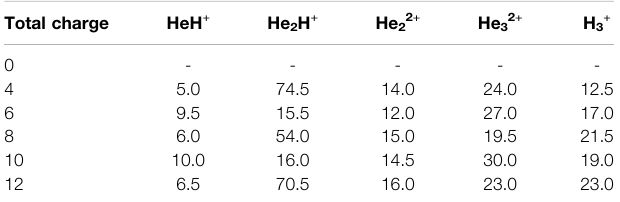
TABLE 5 | Time of occurrence (in fs) of different species from the AINR simulation ofa 1:3 ratio ofhelium tohydrogen while varying the temperature, with a fi xed total positive charge of system (8 +